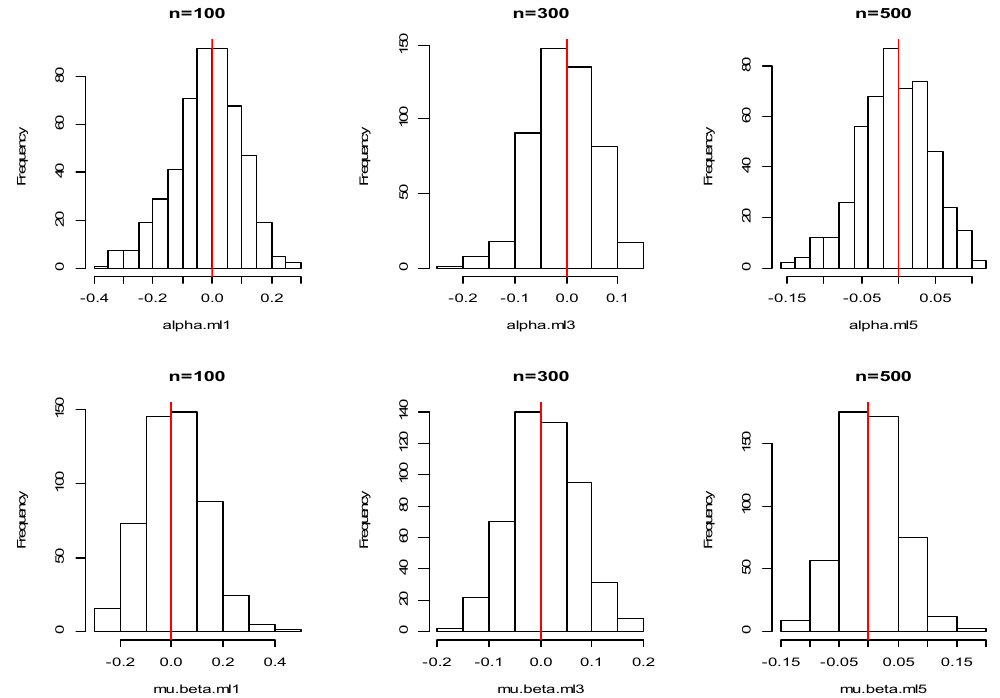
α μ and β with maximum likelihood method in Case 1 .